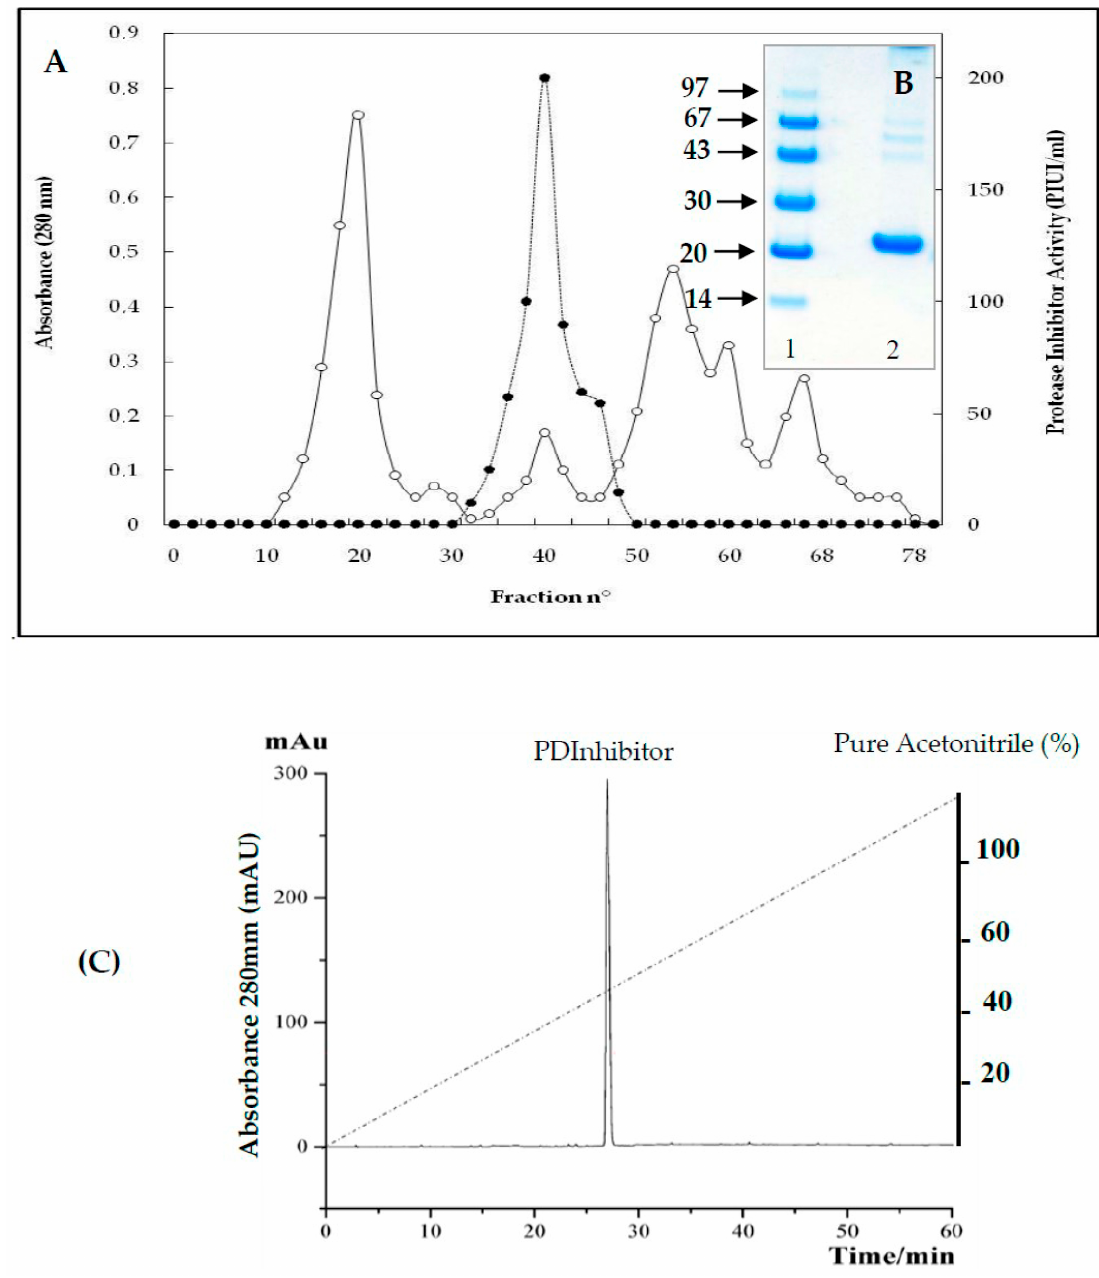
Figure 1. Purification of PDInhibitor. ( A ) Gel filtration chromatography using a Sephadex G-50 column. A G-50 column (2 × 100 cm) was equilibrated with 0.1 Μ Tris-HCL buffer (pH 8) containing 0.2 Μ NaCl. The column was eluted at 4 °C with the same solution at a flow rate of 30 mL/hand, and 4.0 mL fractions were collected. ( B ) SDS-PAGE for Conyza dioscoridis protease inhibitor. 1: molecular markers (14 kD, 20 kD, 30 kD, 43 kD, 67 kD and 97 kD); 2: Sephadex G-50 PDInhibitor. ( C ) A reversed-phase analytical HPLC on C-8 column. A reverse phase RP-HPLC eurospher 100, C-8 column (250 × 4.6 mm), was equilibrated with 0.1% TFA in water. Protein elution was performed with an acetonitrile linear gradient (0–100%) at a flow rate of 1 mL/min over 60 min. 20µL of PDInhibitor (1 mg/mL) was used.